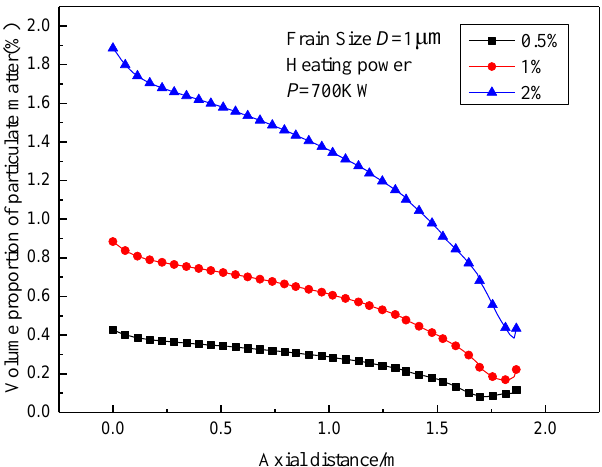
Figure 12. Particle concentration distribution in the heating section under di ff erent initial particle concentrations.